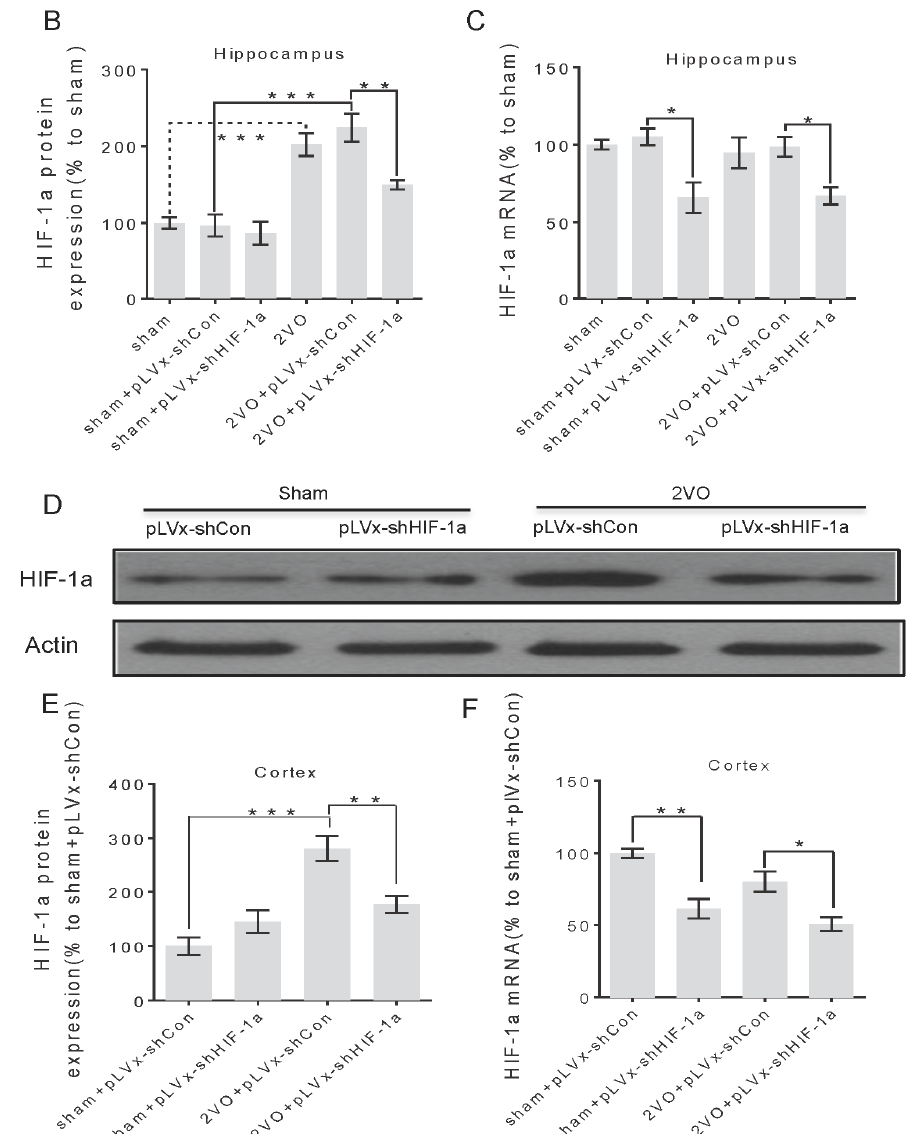
Figure 2. The effects of lentiviral-mediated shRNAi on HIF-1 α mRNA expression and protein accumulation under four-week hypoperfusion. ( A , B ) Western blot analysis of HIF-1 α protein levels in hippocampus of 2-vessel occlusions (2VO) or sham rats that received stereotaxic injection of pLVx-GFP-shCon or pLVx-GFP-shHIF-1 α . As blank control, 2VO or sham rats without stereotaxic injection were also included in our study; ( C ) qRT-PCR analysis of HIF-1 α mRNA levels in hippocampus of rats in each group; ( D , E ) Western blot analysis of HIF-1 α protein levels in cortex of rats in each group; ( F ) qRT-PCR analysis of HIF-1 α mRNA levels in cortex of rats in each group. Values for HIF-1 α protein and mRNA were normalized to β -actin protein or mRNA, respectively. Values are expressed as a percentage of the average value for the first group on the left and are means ± SEM ( n = 4–5). * p < 0.05 and ** p < 0.01, *** p < 0.001 (one-way ANOVA followed by Bonferroni post hoc